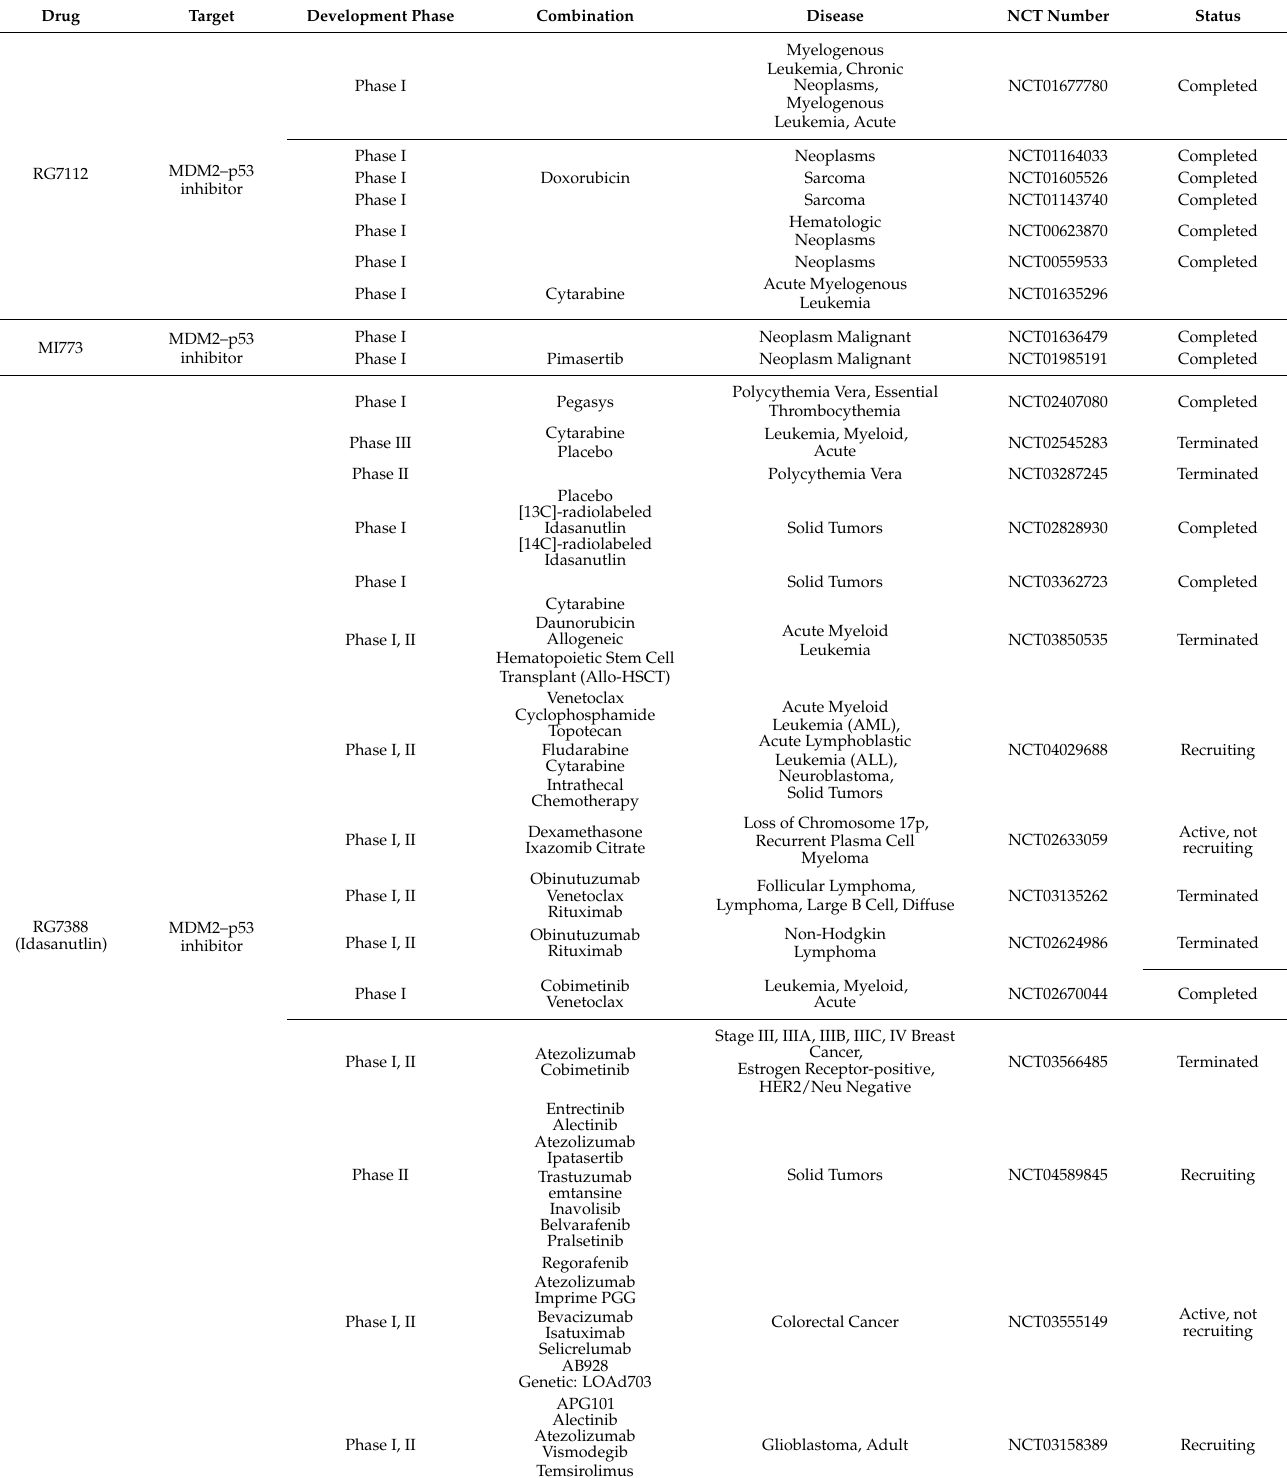
Table 5. Clinical trials of wild-type and mutant p53